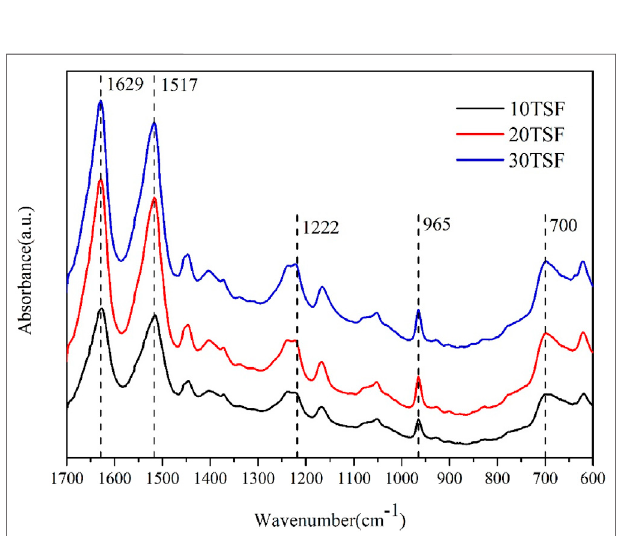
FIGURE 4 | FTIR spectra of TSF nano fi ber mats after 10-, 20-, and 30- min physical shearing.